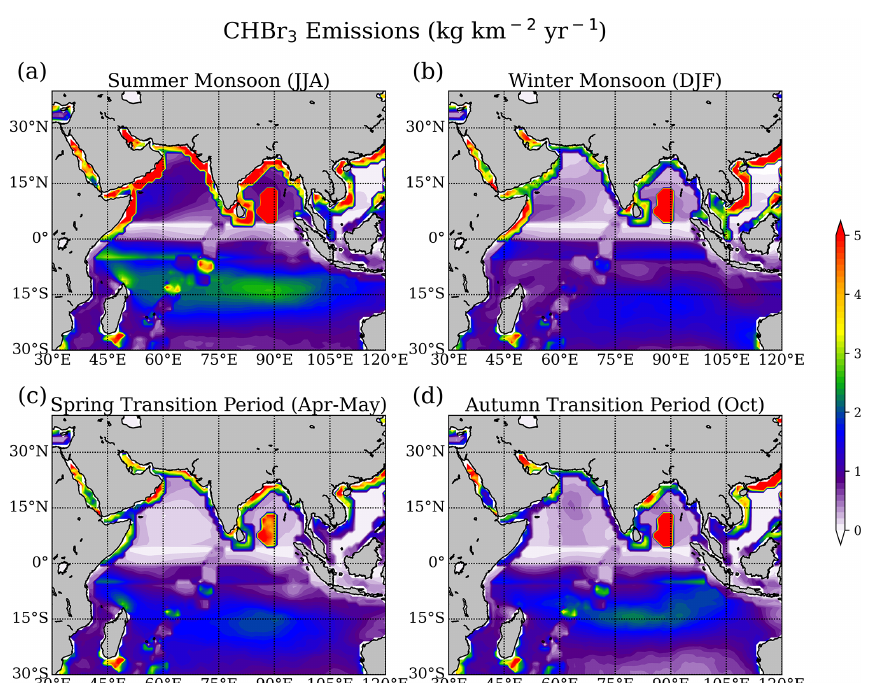
Figure 10. Bromoform (CHBr 3 ) emission for (a) summer monsoon (June–August), (b) winter monsoon (December–February), (c) spring transition (April–May), and (d) autumn transition (October) based on static surface concentrations and ERA-Interim meteorology for 2014 (Fiehn et al.,